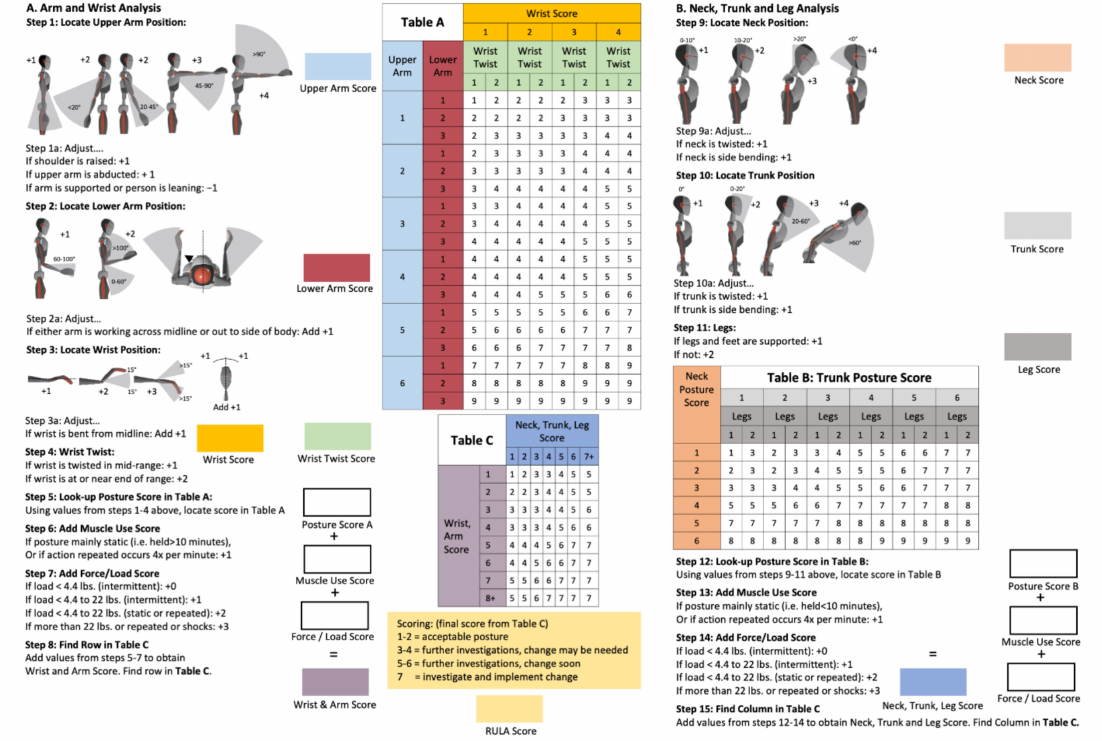
Figure 2. The Rapid Upper Limb Assessment (RULA) Worksheet [38]. The “( A ) Arm and Wrist Analysis” consists of 8 steps (steps 1–8), which are added to the “Wrist and Arm Score” (left side). On the right side “( B ) Neck, Trunk and Leg Analysis”, steps 9–15 are added to the “Neck, Trunk, and Leg Score”. The combination of the “Wrist and Arm Score” and the “Neck, Trunk, and Leg Score” using table C leads to the final RULA